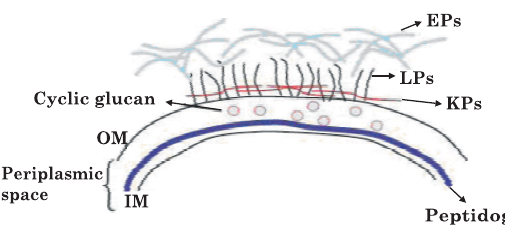
Figure 1. Schematic representation of bacterial surface polysaccharides. EPS: exopolysac- charides; KPS: exopolysaccharides attached to the bacterial surface; LPS: lipopolysaccharides; IM: cell internal membrane; OM: cell outer membrane (Source: Lepek & D’Antuono,